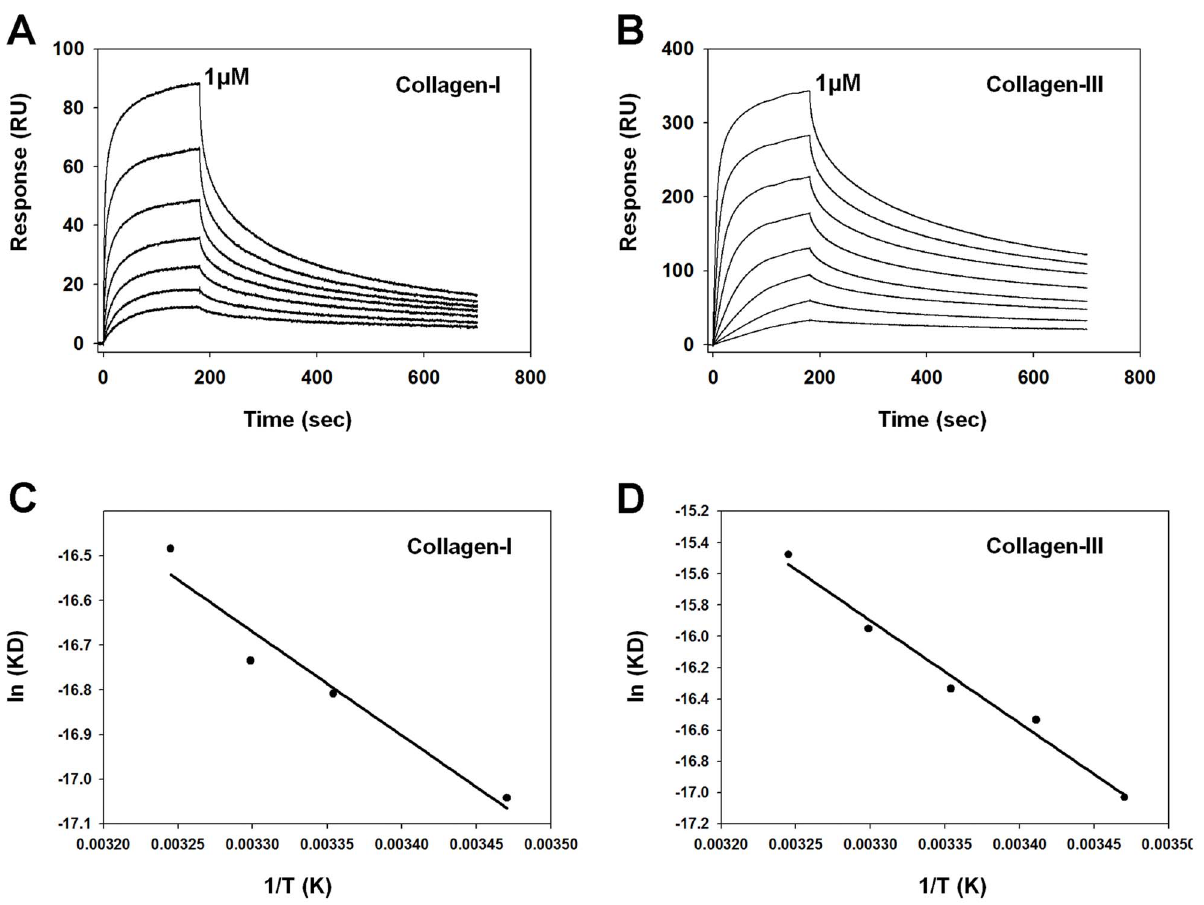
Figure 4. Kinetic and thermodynamic analysis of Simplagrin collagen interaction. (A) and (B) Simplagrin at different concentrations was flowed over immobilized collagen for 180 seconds at 30 m L/mL and the collagen Simplagrin dissociation monitored for 600 seconds. The response data were fitted to a 1:1 interaction model using global analysis. Simplagrin displays high affinity for collagen type I and III. (C) and (D) Thermodynamic parameters of Simplagrin collagen (I and III) were obtained from independent kinetic experiments using surface plasmon resonance (SPR). D H and D S were obtained using the van’t Hoff equation. All SPR experiments were carried out in triplicate. Results are representative of typical sensograms. Molar concentrations of collagen were calculated assuming an MW of 250 kDa.